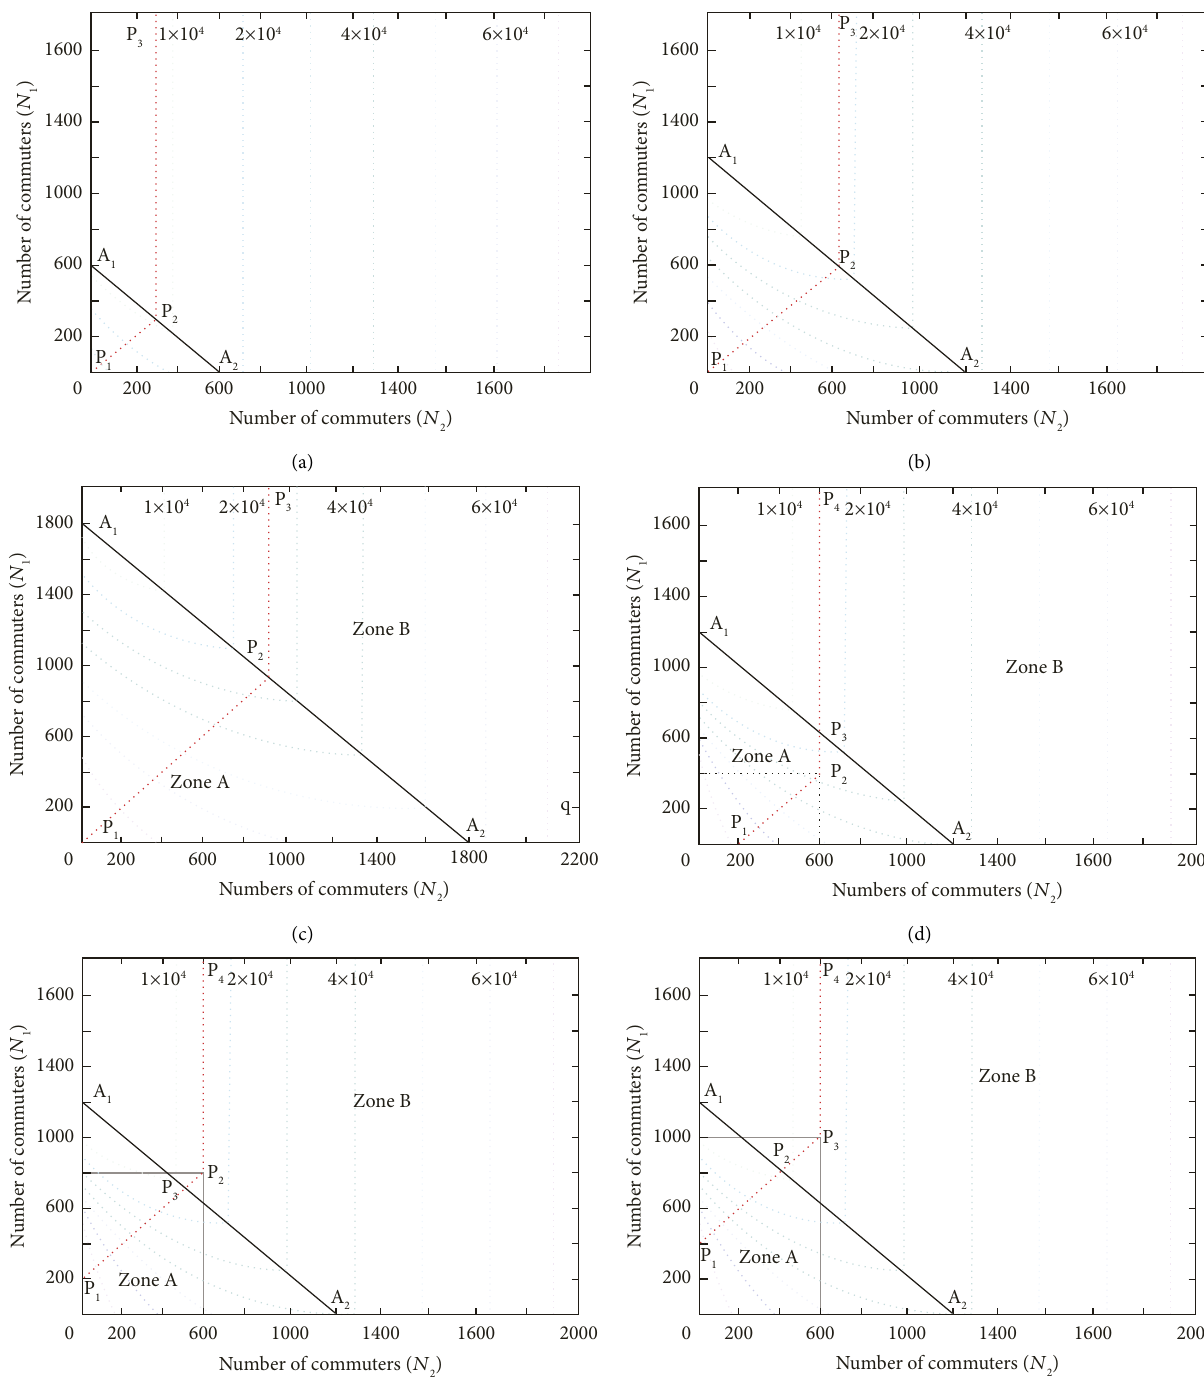
Figure 5: Equilibrium allocation detail between passengers with different desired departure